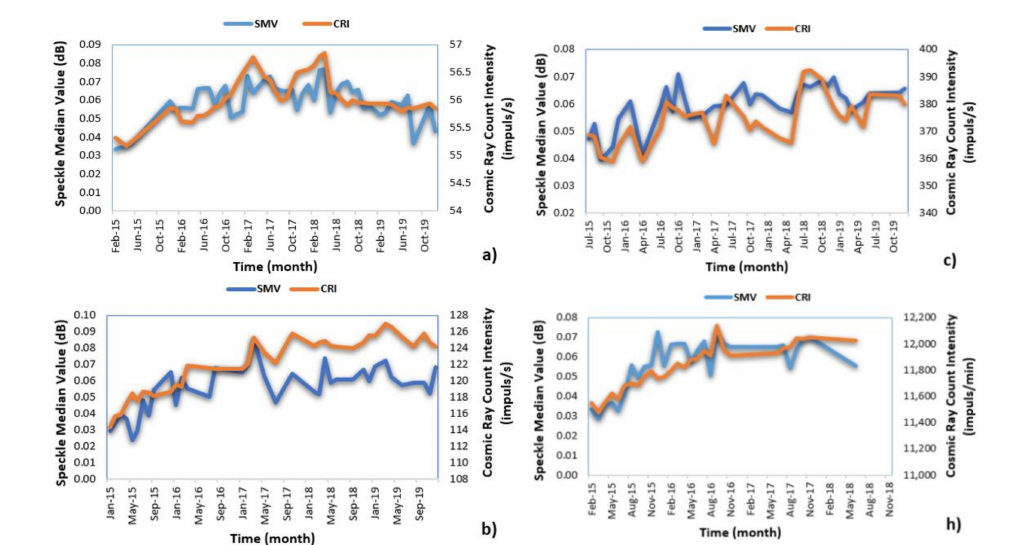
Figure 3. Temporal variation graphs of speckle median values and cosmic ray number intensity values: ( a ) Athens (Greece), ( b ) Baksan (Russia), ( c ) NM64 NM Jungfraujoch (Switzerland) and ( d ) Tsumeb